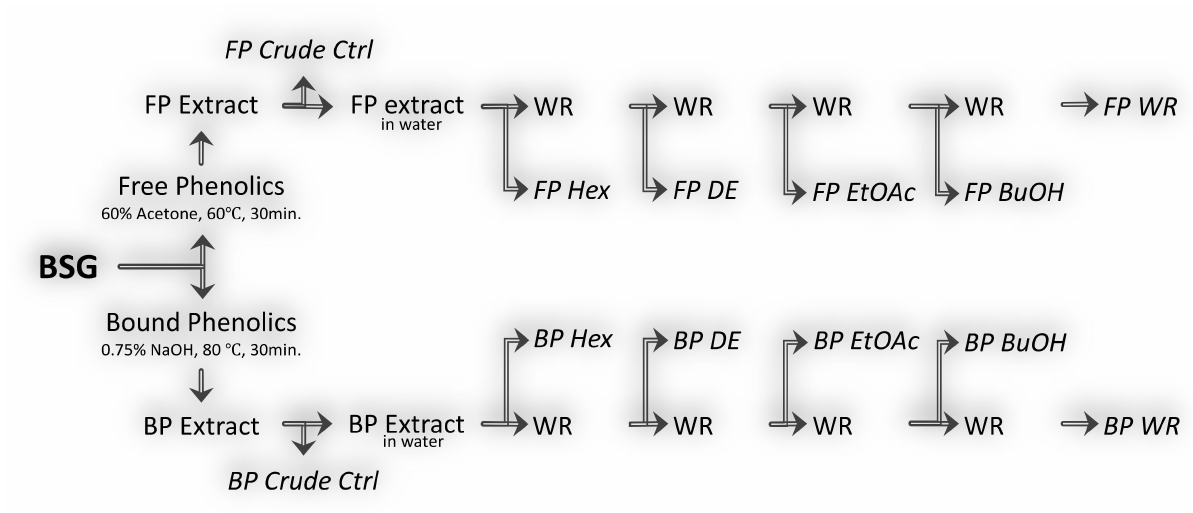
Figure 1. Extraction process of free and bound phenolic compounds from BSG followed by their partitioning using different organic solvents. FP—free phenolics, BP—bound phenolics, WR—water residue, Hex—hexane, DE—diethyl ether, EtOAc—ethyl acetate, BuOH—butanol,